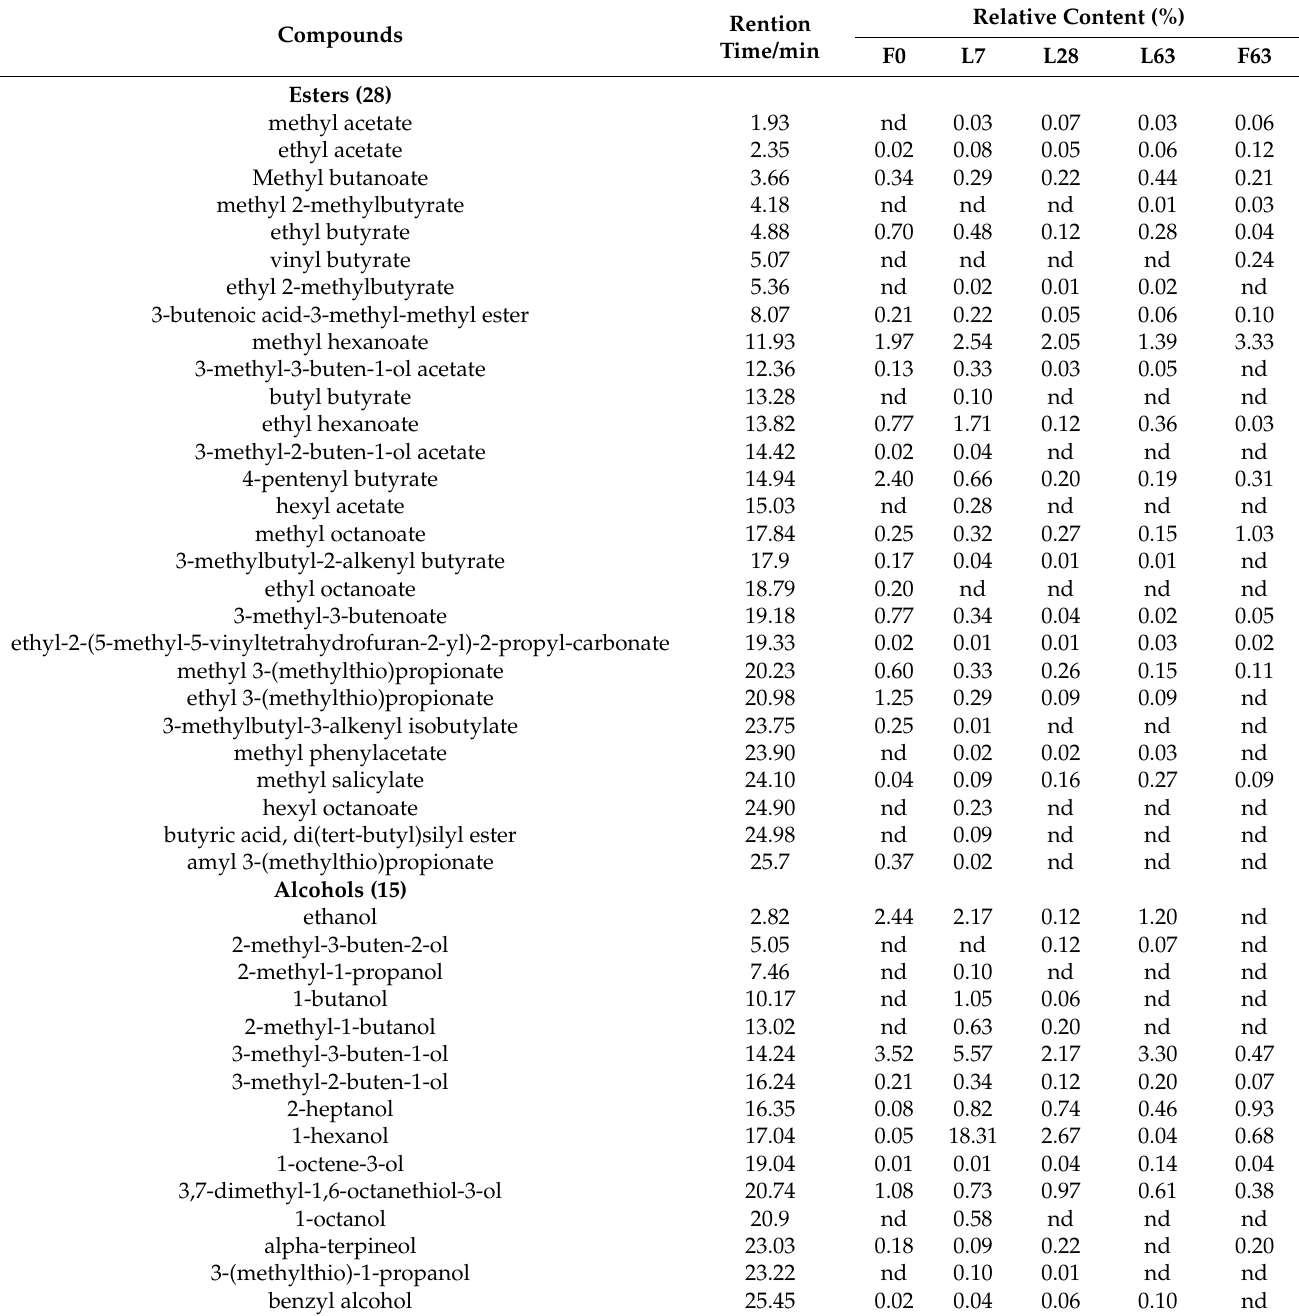
Table 1. Volatile compounds of noni juice at different fermentation times and